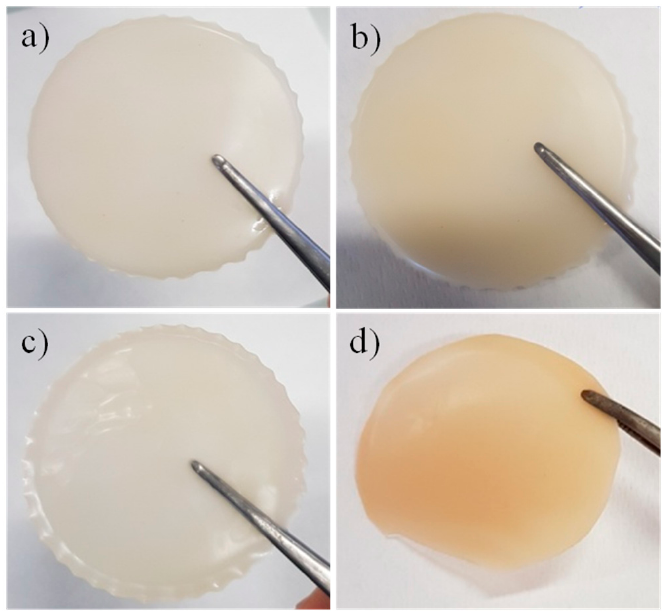
Figure 1. Photos of the prepared GPEs based on: ( a ) PAN, ( b ) PAN/org-SW, ( c ) PAN:PEO blend, and ( d ) PAN:PEO/org-SWy.